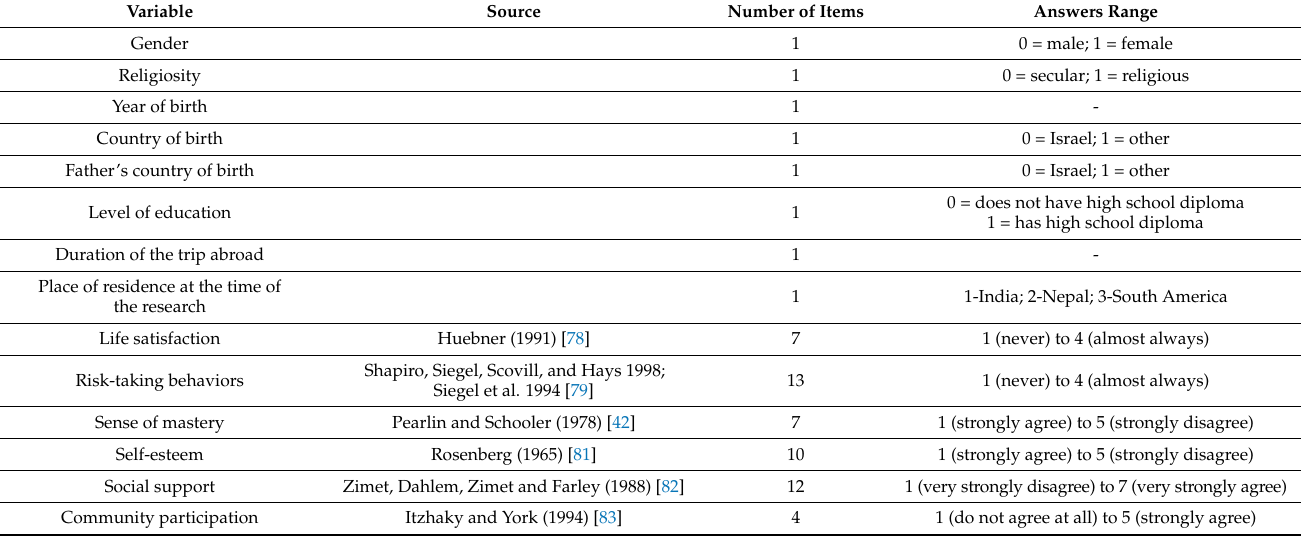
Table A1. Scales used in the